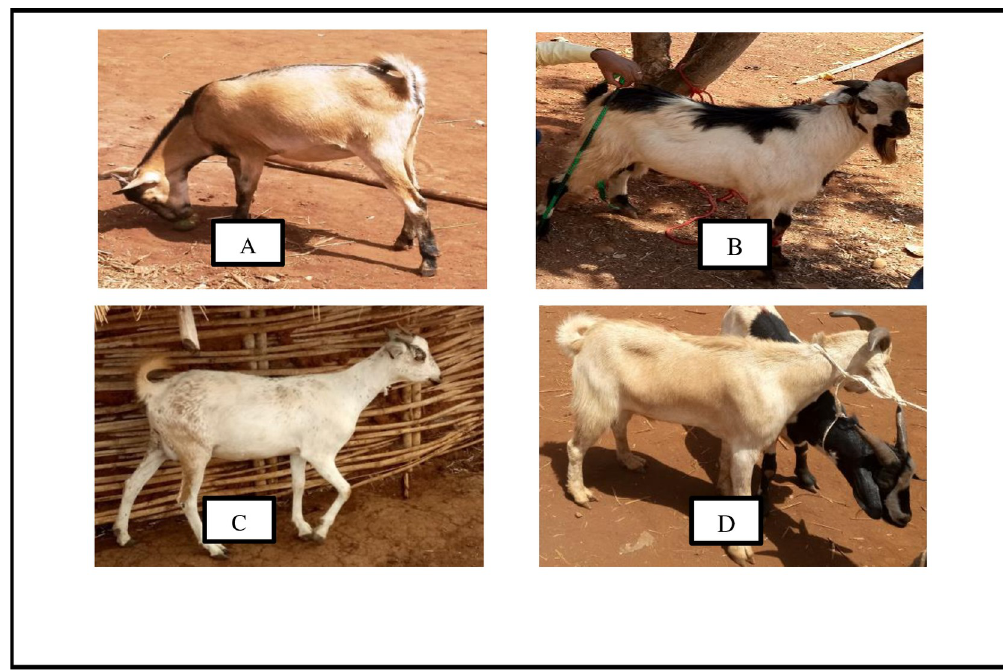
Fig 1. Representative pictures of adult Arab doe (A), young Arab buck (B), adult Oromo doe (C) and adult Oromo buck (D) included in the